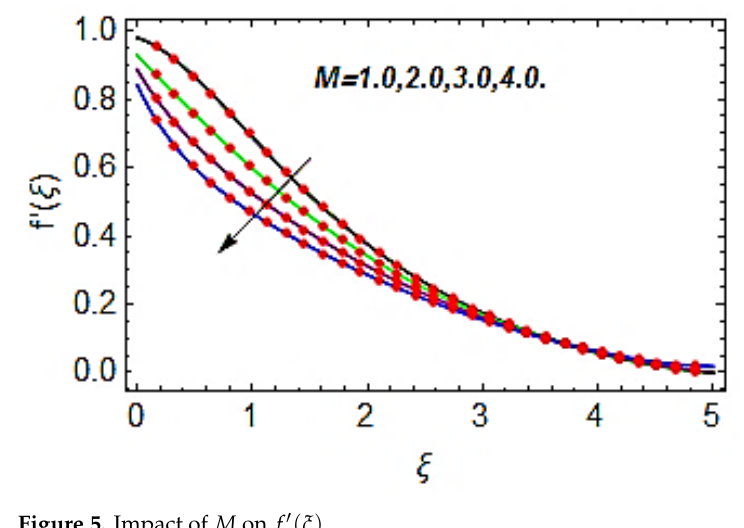
Figure 5. Impact of M on f (cid:48) ( ξ ) .